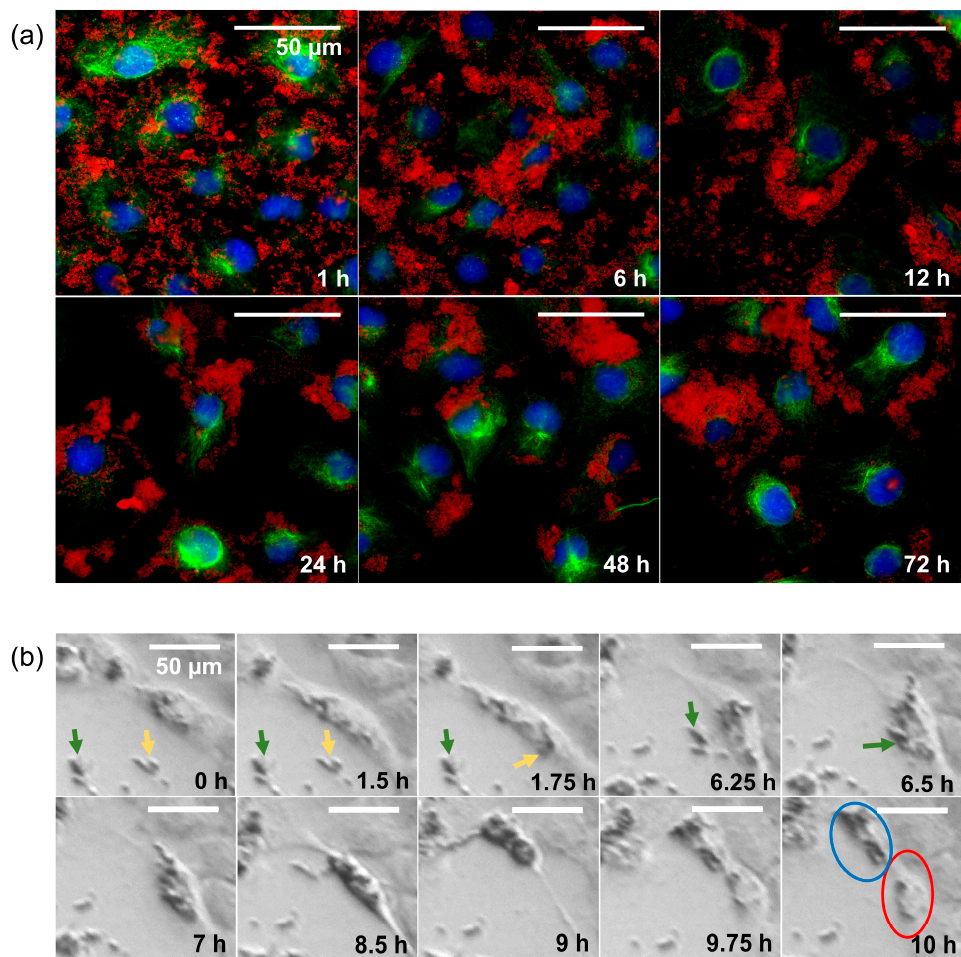
Figure 4. Behavior over time of HNSCC cells interacting with SPIONs. ( a ) Immunofluorescence imaging of RPMI 2650 cells with 20 µ g Fe/mL over time (1, 6, 12, 24, 48, and 72 h); DAPI (blue), α - Tubulin (green), and nanoparticles (red, captured with transmitted light microscope). ( b ) Imaging of the cell division of an HSC-4 cell (HPV-HNSCC cell line) with SPION-APTES over the course of 10 h. Yellow and green arrows point to the aggregates of nanoparticles before uptake by the cell. The blue circle marks the daughter cell with a high content of nanoparticles, and the red circle marks the daughter cell with a low content of nanoparticles.